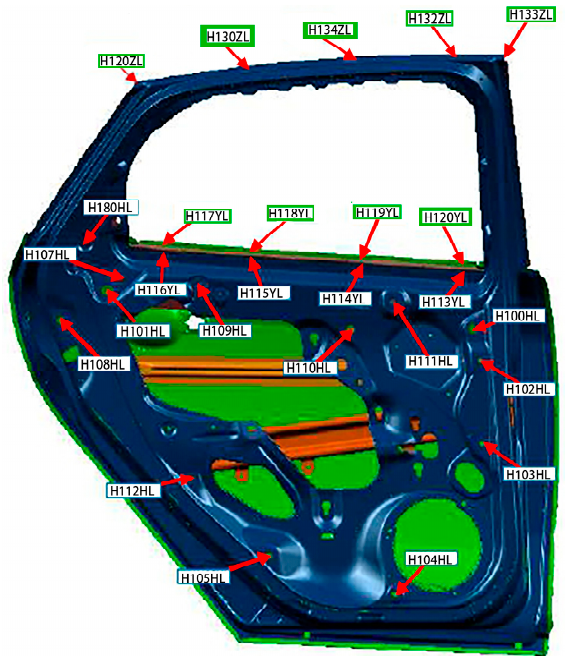
Table 4. Window point analysis table.